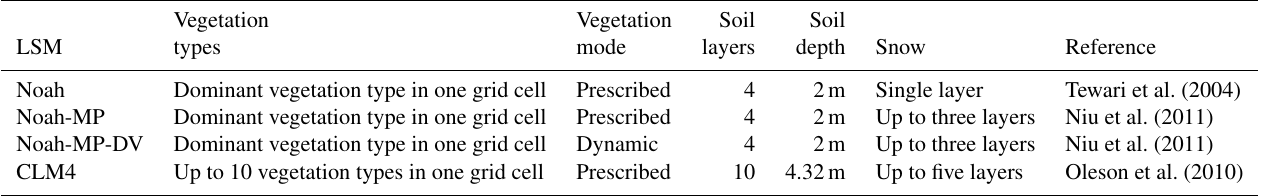
Table 1. Characteristics of the LSM components employed for the WRF simulations performed in this analysis. Vegetation Vegetation